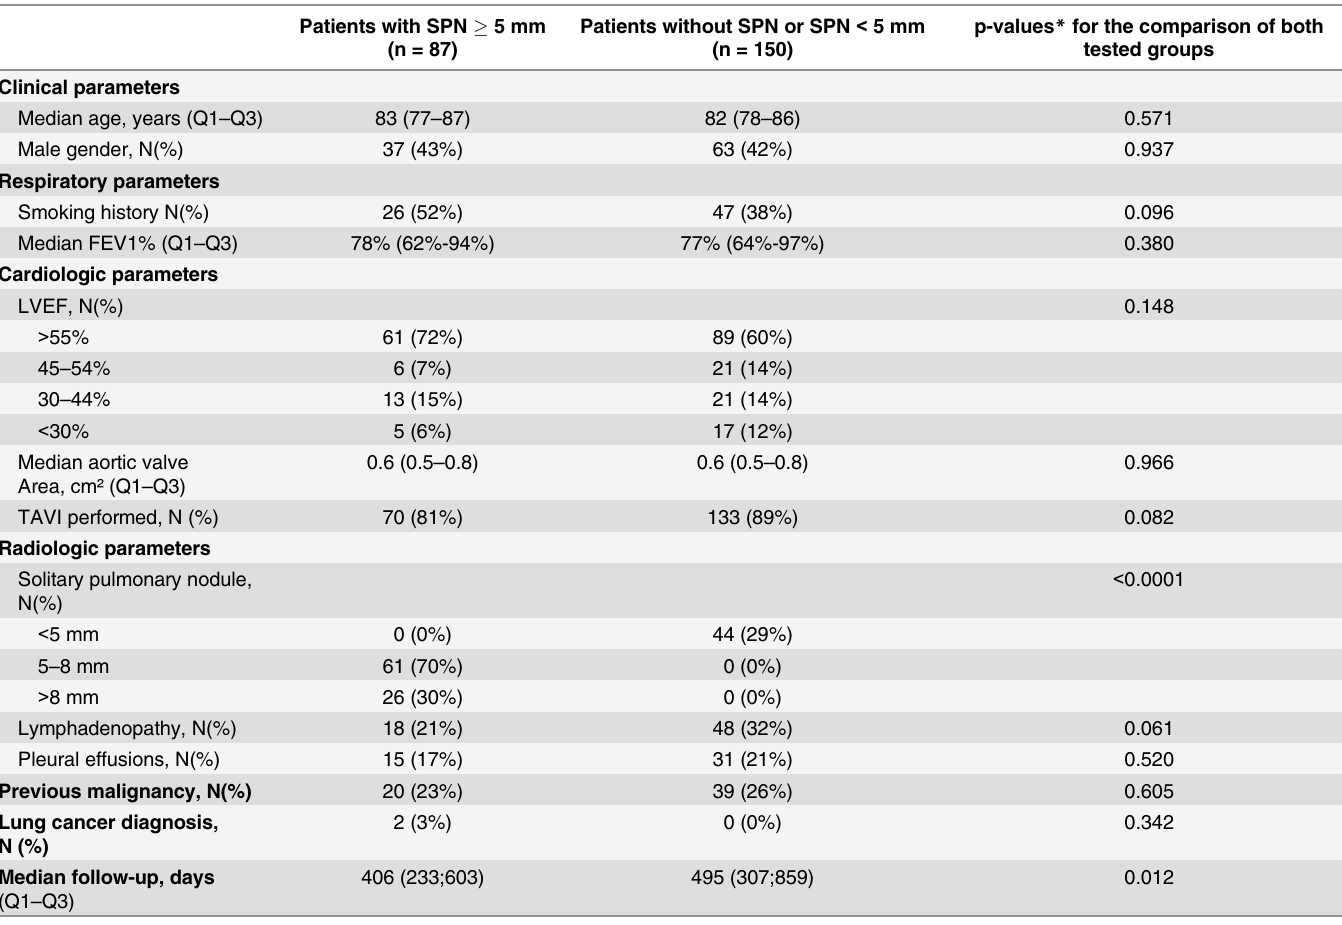
Table 2. Baseline characteristics of patients under TAVI evaluation with complete follow-up data (n = 237